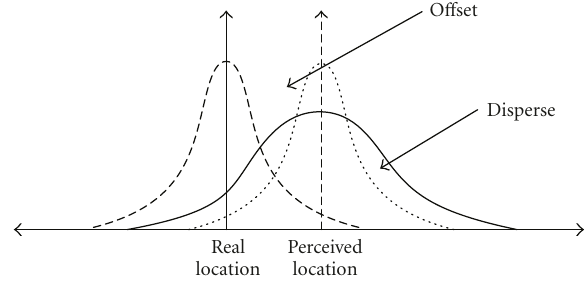
Figure 8: Two types of spatial information loss.